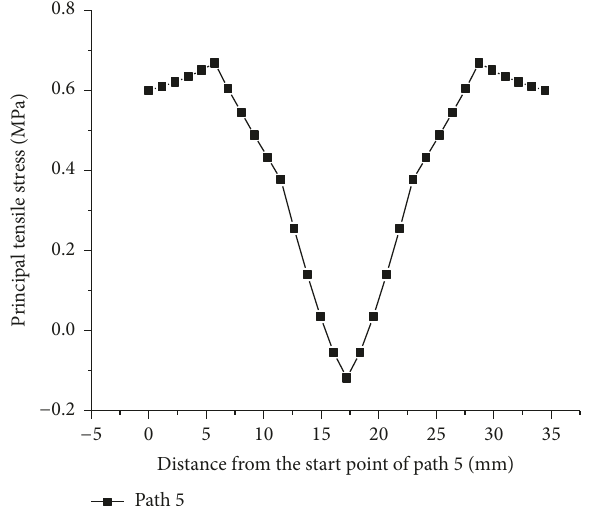
Figure 39: Principal tensile stress in the concrete specimen pre- stressed under a load of 10MPa when the displacement resulting from corrosion-induced expansion reaches 0.031 mm.